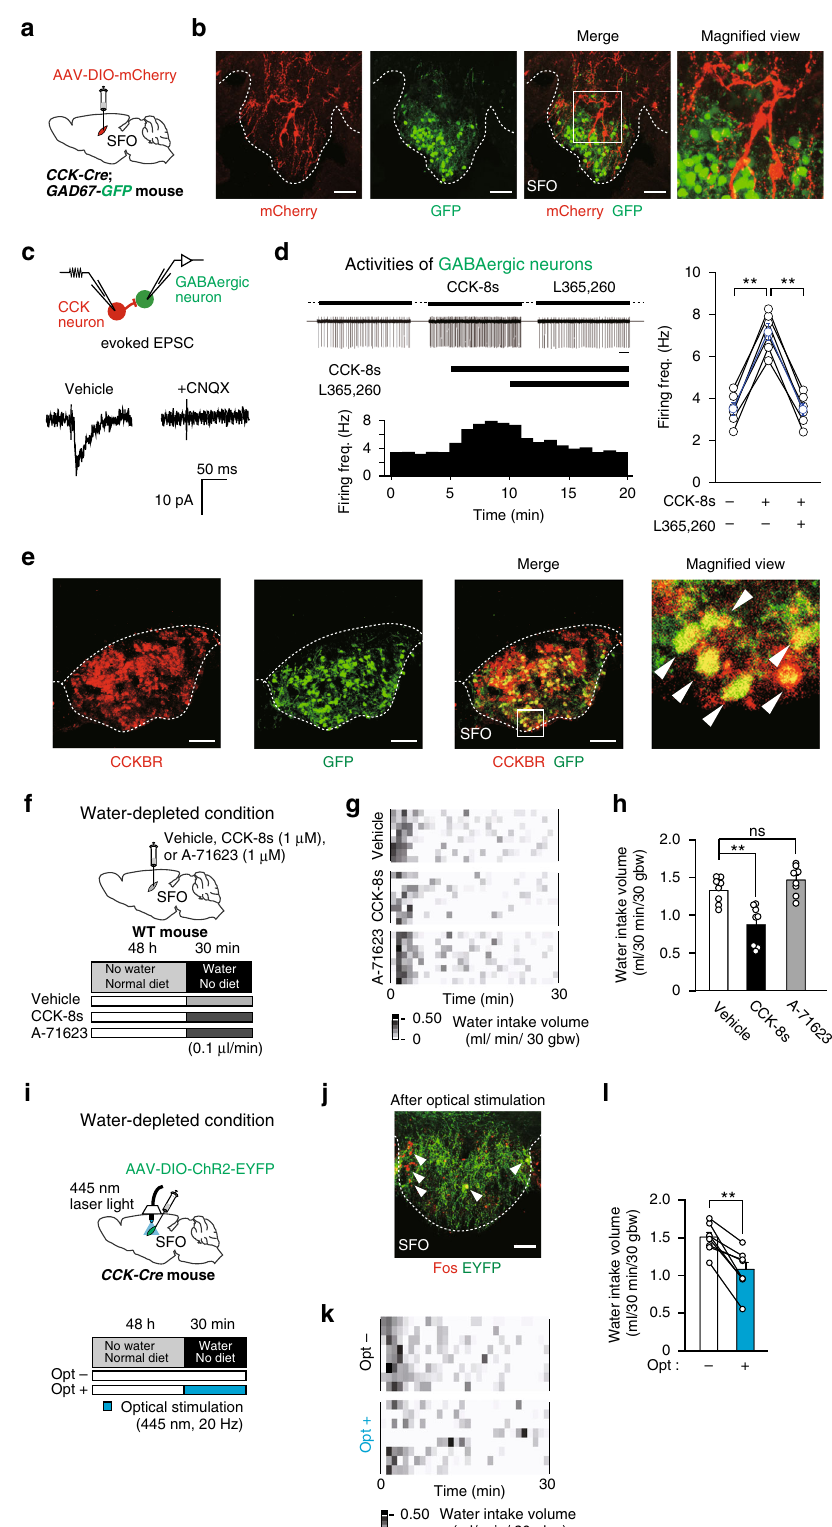
vehicle injection showed the normal enhancement of water intake (1.33 ± 0.06 ml in 30 min; Fig. 2g, h). As was expected, the CCK- 8s injection into the SFO signi fi cantly reduced water intake to 0.87 ± 0.09 ml (Fig. 2g, h), which was equivalent to that in mice with the optical excitation of GABAergic neurons in the SFO (Supplementary Fig. 2d). Of note, the reducing effects on